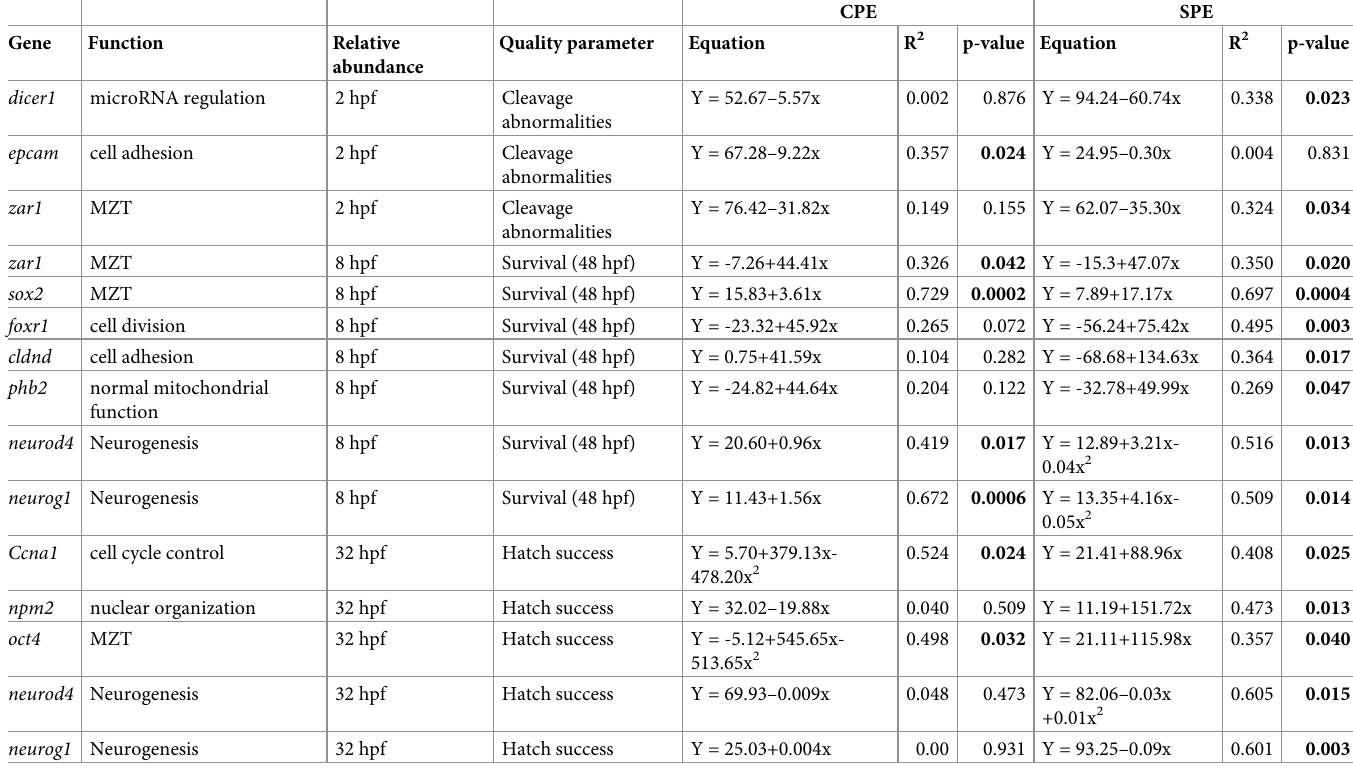
Table 4. Relationship between mRNA abundance of specific genes in eggs and embryos at selected sampling points and offspring quality parameters for the two treatments (CPE and SPE) in European eel, Anguilla anguilla , including best fitting equation and significance levels for genes, where a significant effect was found for at least one of the